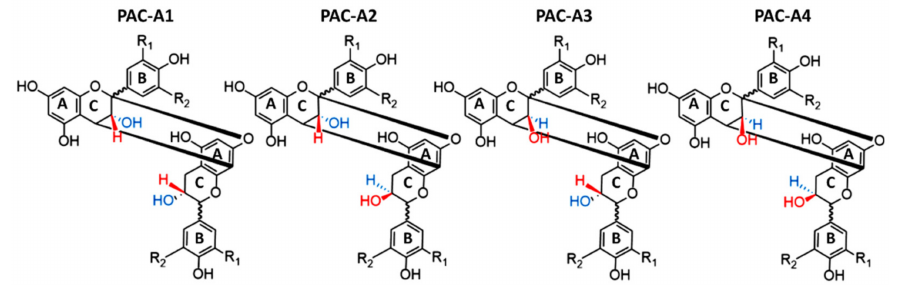
Figure 4. Chemical structures of the different A-type PACs depending on the stereochemistry of substituents. The blue dashed line represents bonds that "sink" below the plane of the sheet, while the red wedged line indicates a chemical bond that is directed towards the